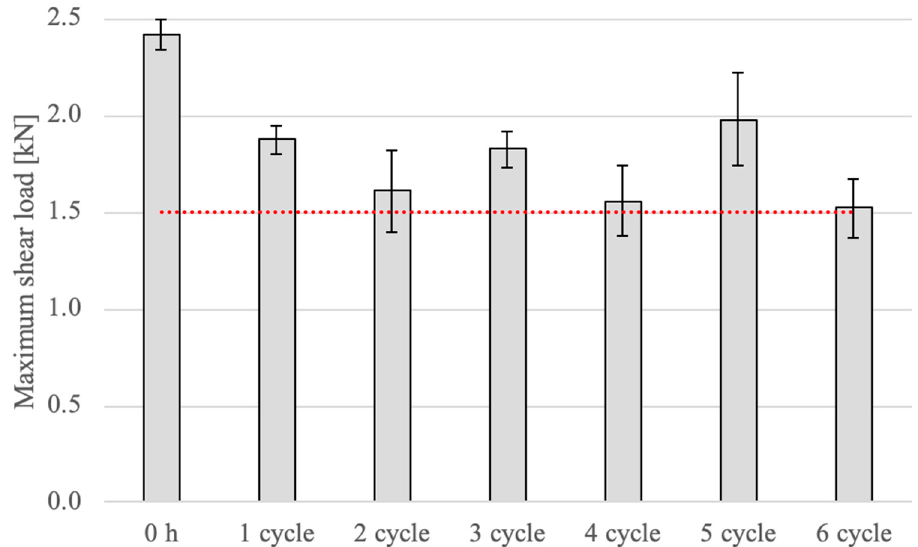
Figure 15. Maximum shear strength of RJS specimens immersed in petroleum oil following a cyclic pattern. The red dotted line represents the threshold value for the RJS specimen’s minimum allowed joint strength (1.5 kN).